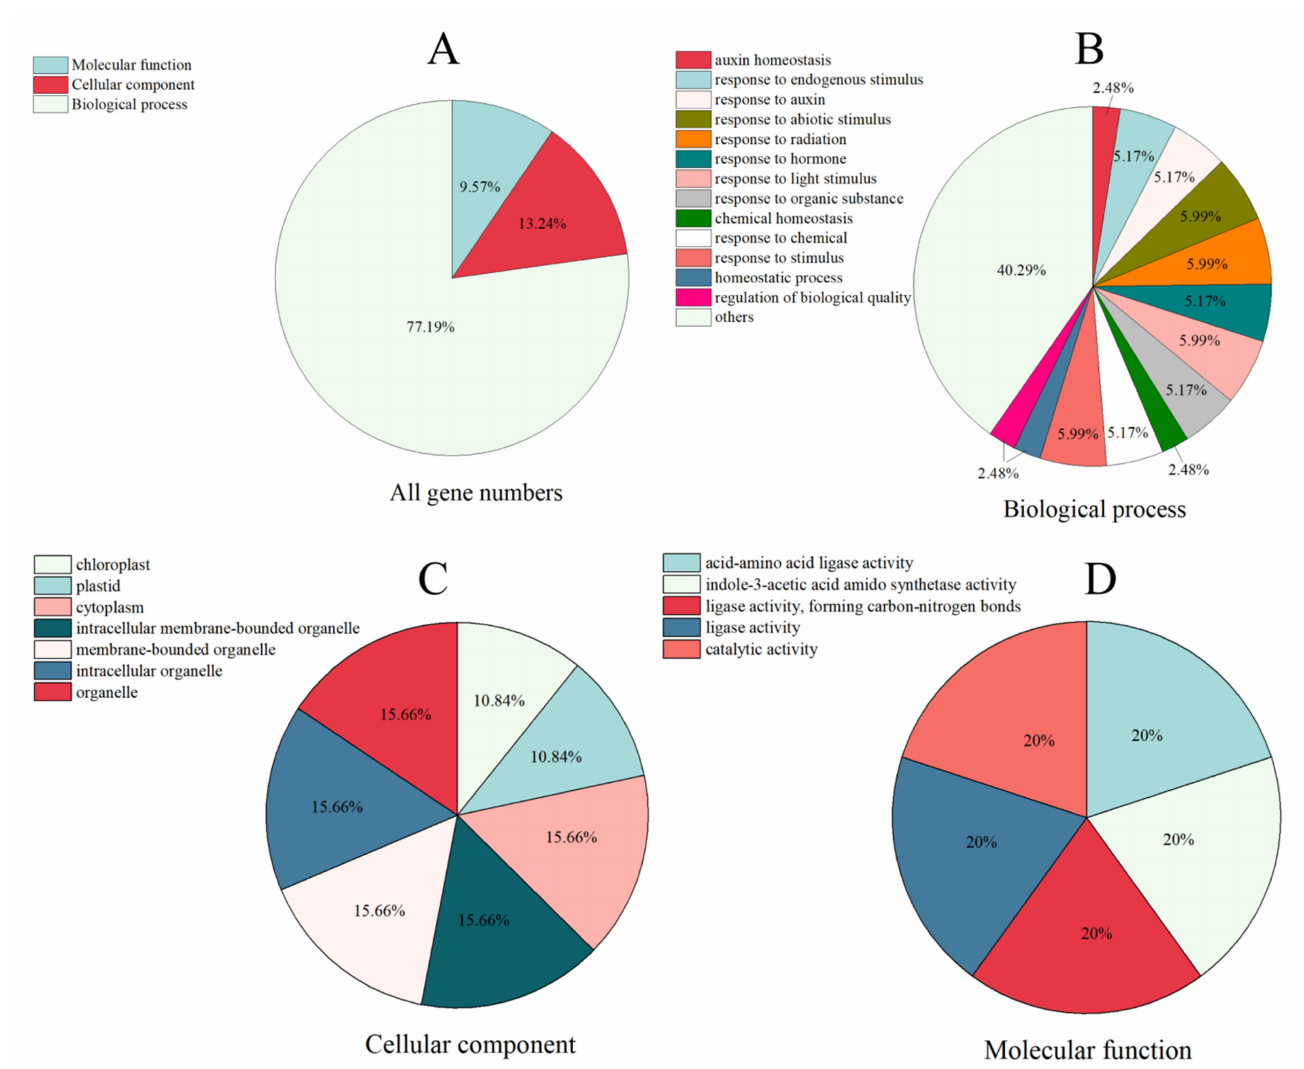
Figure 4. GO annotation of the SsGH3 family genes. GO terms are summarized in three main categories. ( A ) All GO terms in three main categories. ( B – D ) The functional annotation analysis of SsGH3 genes in terms of biological process, cellular component, and molecular function,